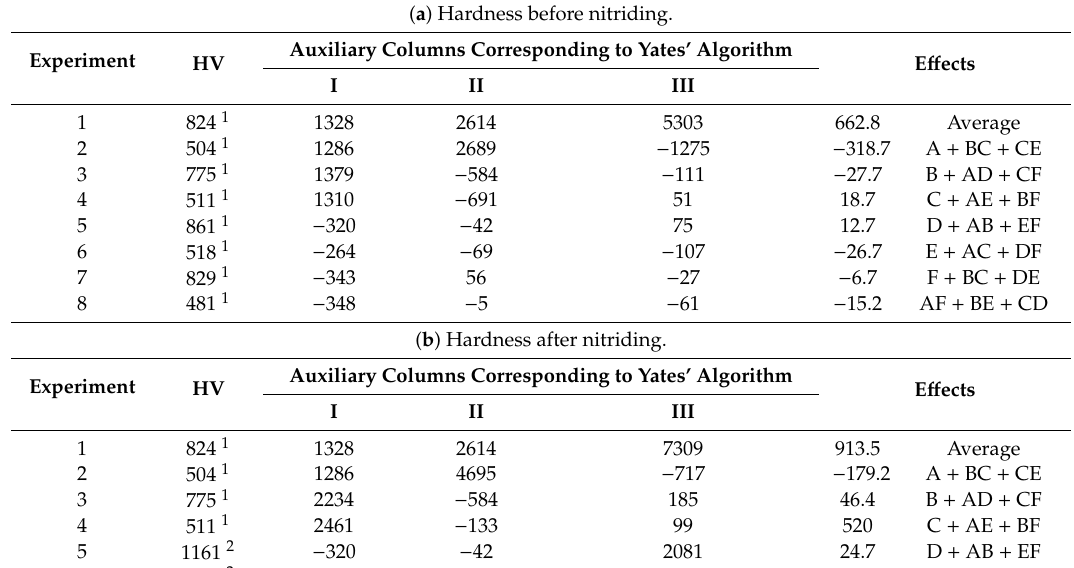
Table 5. Values and e ff ects obtained for the analyzed responses. ( a ) Hardness before